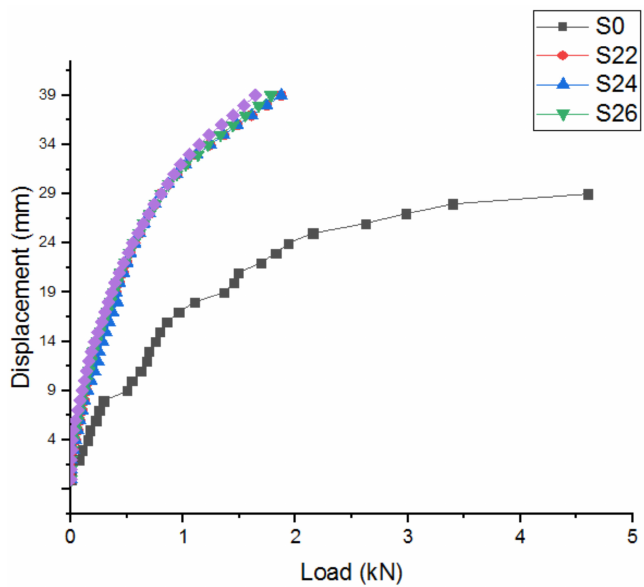
Figure 10. Load–displacement relationships.